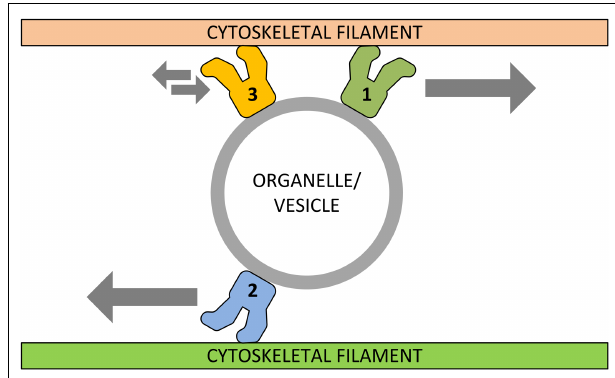
FIGURE 1 | Schematic model of functional cooperation between different motor proteins. In its simplest view, specific motor proteins (1) can transport organelles/vesicles along cytoskeleton filaments toward their final destination. Motors of different (or related) families (2) can counteract this activity in order to distribute correctly the organelle content while other motors (3) can even immobilize organelles/vesicles into specific cellular